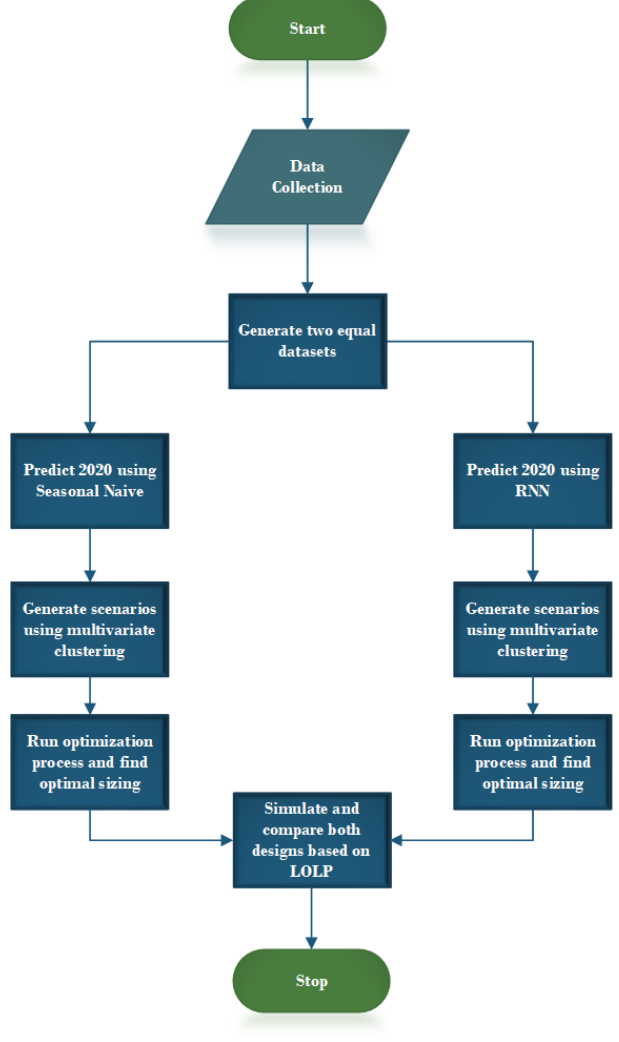
Figure 3. Flowchart of the